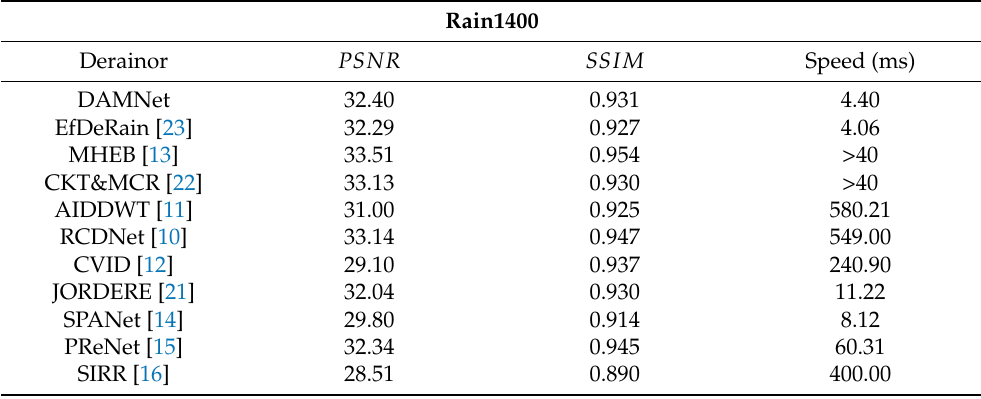
Table 2. Experimental comparison on Rain1400